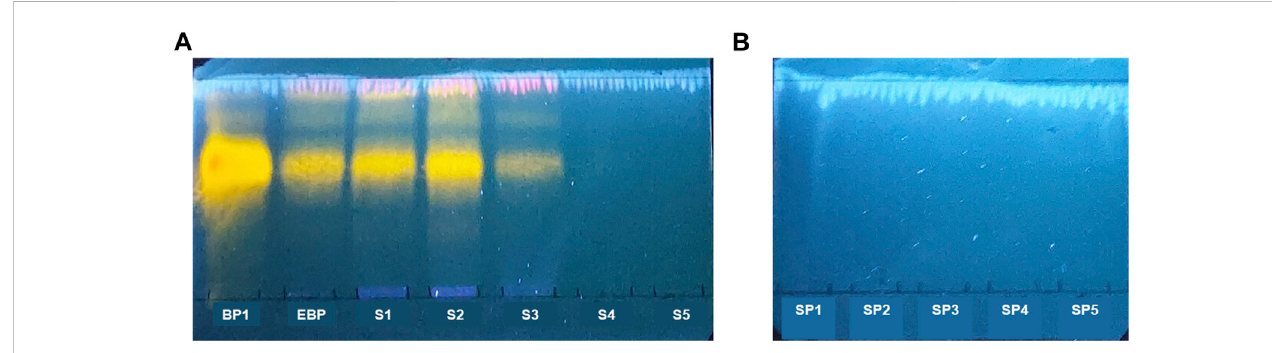
FIGURE 1 TLC of the gel formulation containing B. pinnatum leaf extract. Mobile phases: ethyl acetate: formic acid: methanol: water (10:0.5:0.6:0.2, v/v / v/v ). Adsorbent: silica gel 60 F254. Detection: Natural Product Reagent A at 0.5%. Visualization: UV 365 nm. (A) Solution extractions with methanol from the gel containing B. pinnatum leaf extract (S 1 – 5). Bp1, standard quercetin 3- O - α -L-arabinopyranosyl-(1 → 2)- O - α -L-rhamnopyranoside; EBP, B. pinnatum leaf extract. (B) Solution extractions of the placebo gel (SP = 1 – 5).